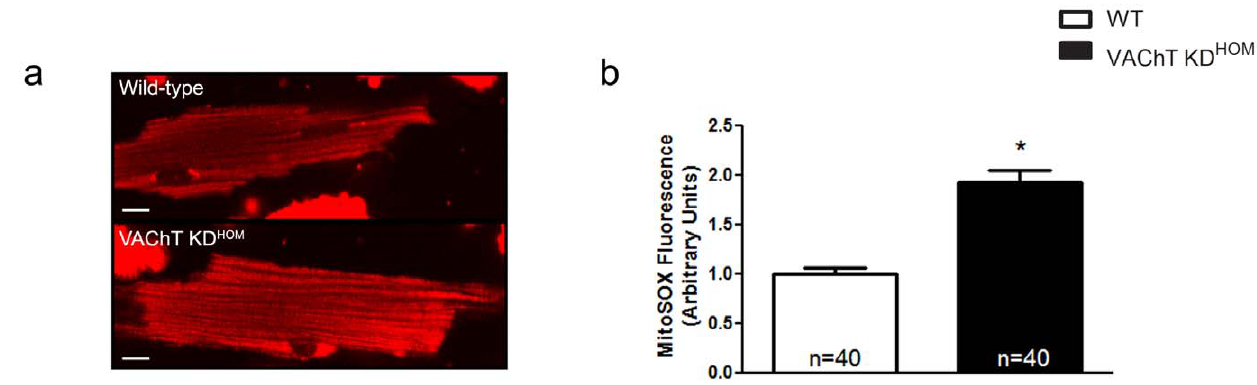
Figure 3. VAChT KD HOM cardiomyocytes show increased levels of ROS. Isolated cardiomyocytes loaded with a MitoSOX superoxide indicator reveal greater ROS levels in mutant myocytes (sample image; panel a ). A robust, significant increase in fluorescence was observed in the KD cardiomyocytes as compared to wild-type control cells ( panel b ). Data represent the mean 6 SEM, with n indicated within bars. *p , 0.05 versus wild- type mice. Scale bar=10 m